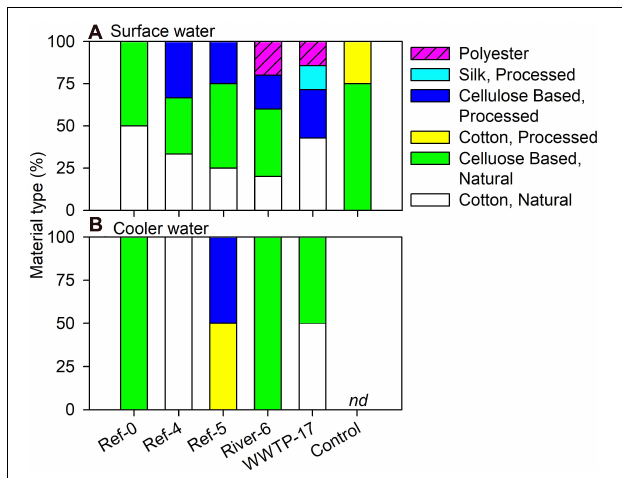
FIGURE 7 | Relative abundance (%) of microplastic particles by polymer type in (A) surface and (B) cooler water in Milwaukee Harbor in July 2018. Ref, reference; WWTP, wastewater treatment plant; nd, no